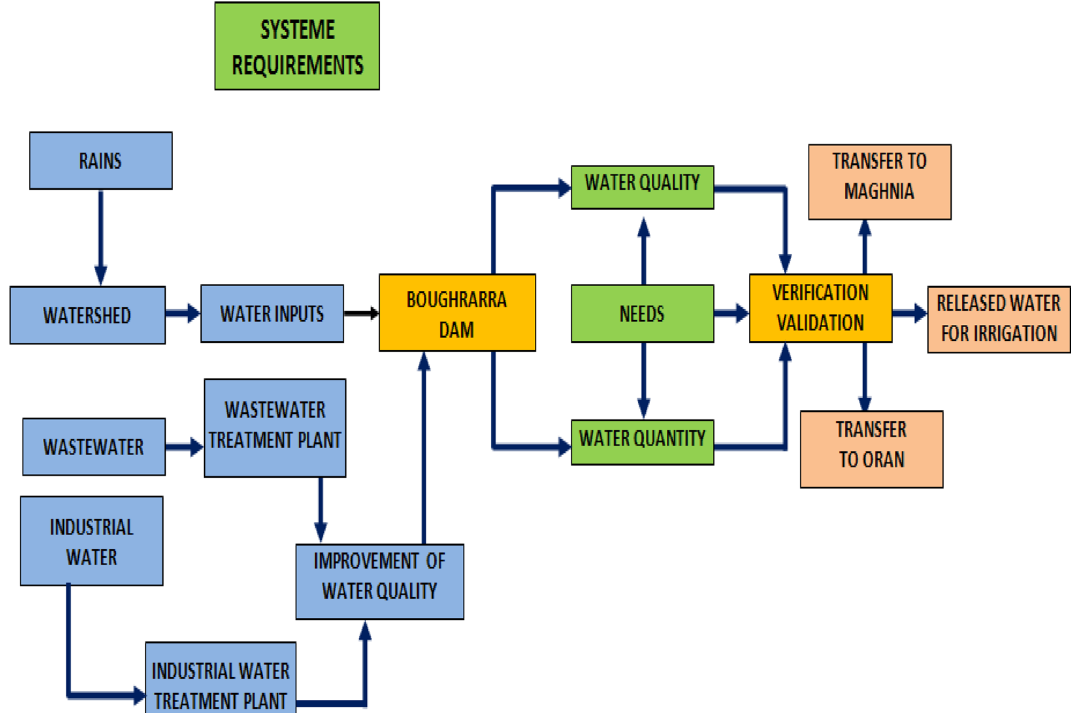
Fig. 5 Functional diagram of the System in relation to its